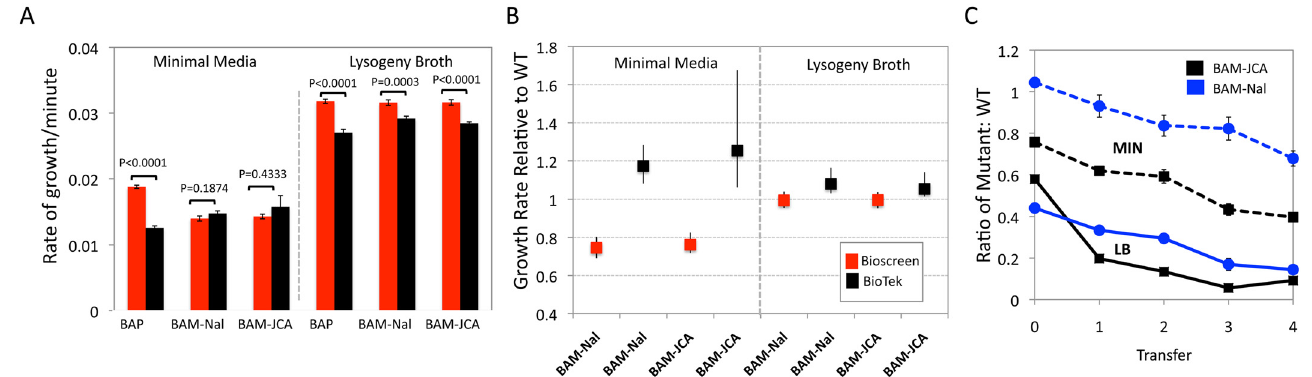
Fig 5. Malthusian parameter and pairwise competition estimates of fitness for E . coli antibiotic sensitive and resistant mutants and transconjugants in LB and glucose-limited minimal medium. (A) Estimates of the MP in minimal medium (left panel) and broth (right panel), Bioscreen (BS, red bar) and BioTek (BT, black bar). (B) Relative to WT growth rates of BAM-Nal and BAM-JCA in minimal and broth. (C) Ratio of antibiotic sensitive (WT) and resistant mutants in pairwise competition; BAM-Nal and WT (blue) and BAM-JCA and WT (black). Mean and standard error for 3 independent cultures from the same initial